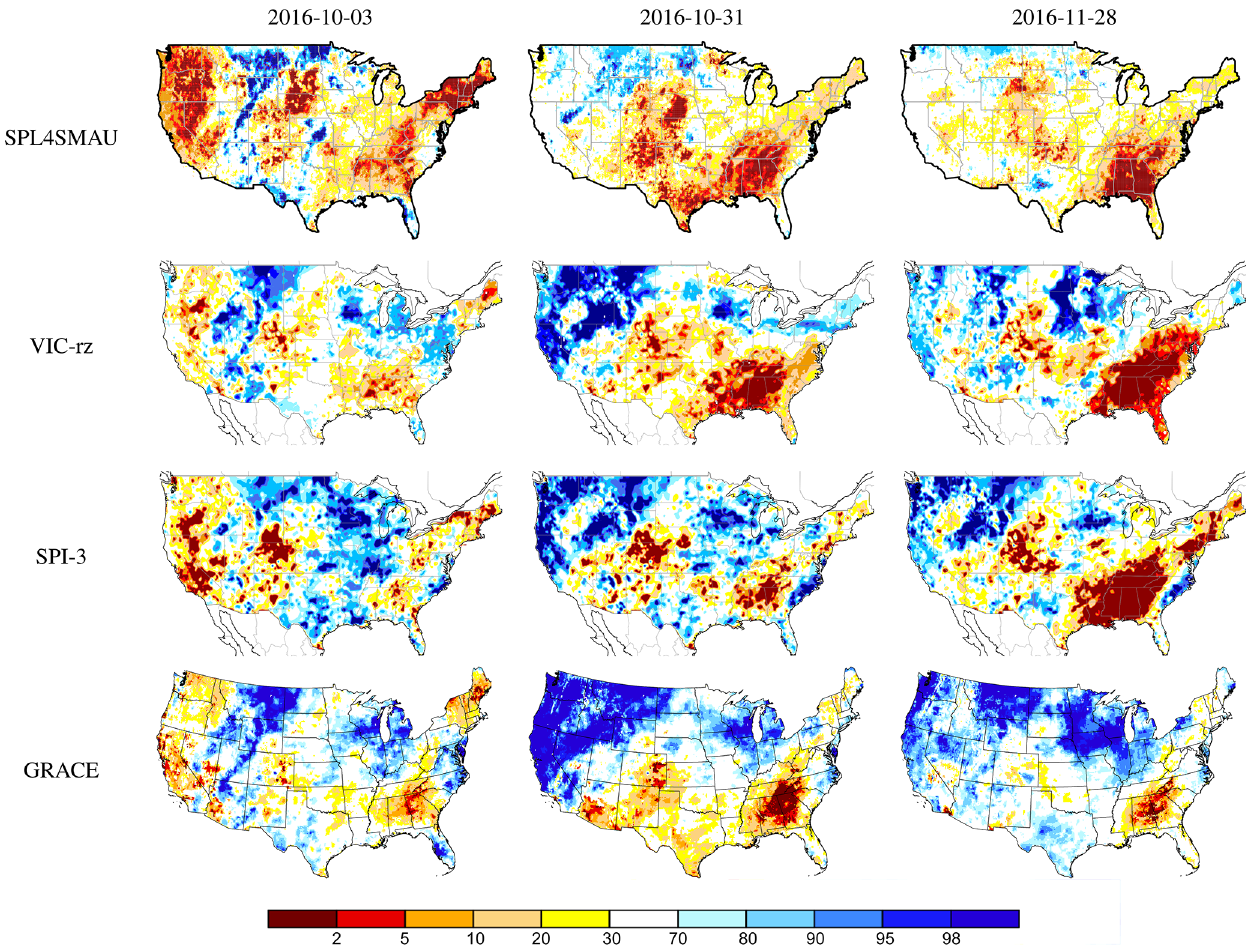
Figure 10. Comparison between SPL4SMAU index map and VIC-rz, SPI-3 and GRACE in